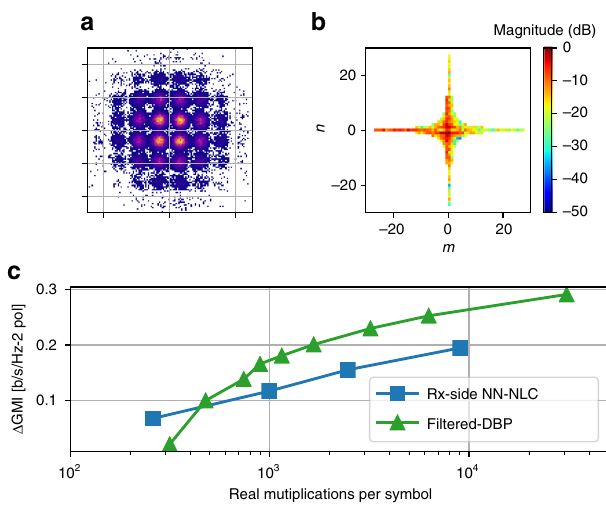
Fig. 10 Undersea cable performance. a The received PS-64QAM constellation after de-noising; b the density map of the input layer tensors; c GMI performance of Rx-side NN-NLC and fi